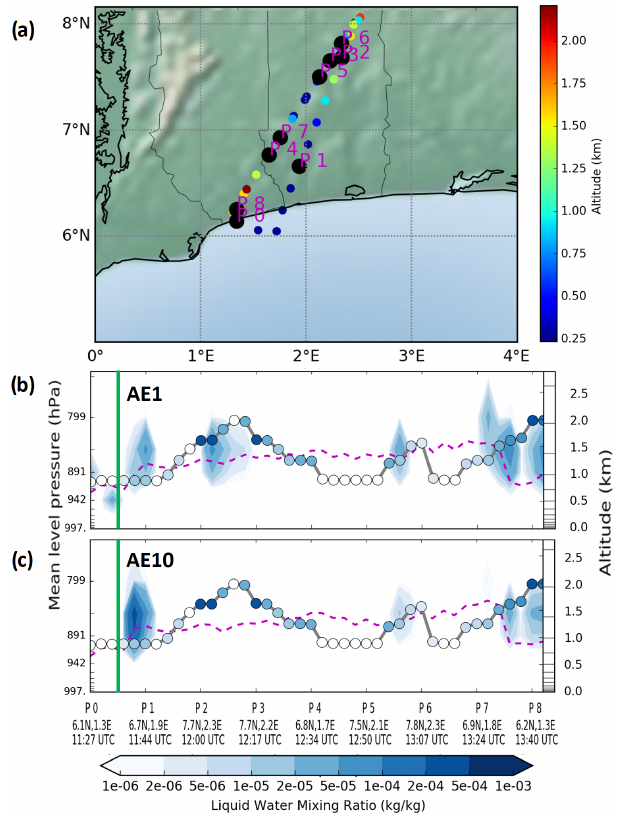
Figure 6. Vertical cross section of the liquid water mixing ratio (in kgkg − 1 ) along the trajectory of the Falcon-20 research aircraft on 5 July 2016 denoted on the map (a) . The 3min averaged observa- tions are displayed by the colored circles and the modeled vertical distribution along the flight positions by the colored fields for the two experiments: (b) AE1 and (c) AE10, with modeled planetary boundary layer height (dashed violet line). The green bars indicate the time of the picture taken from the cockpit presented in Fig. A2).